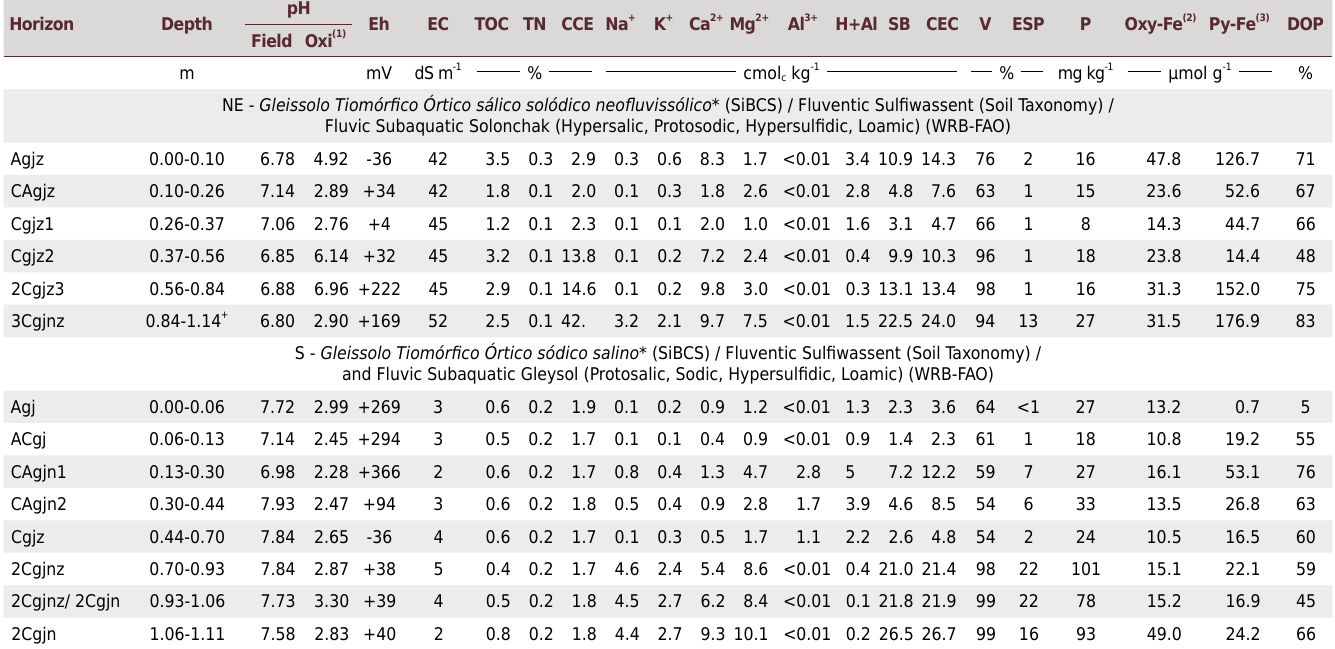
66 (1) pH values recorded after sample oxidation with H (2) Iron associated to oxyhydroxides. (3) Iron associated to pyrite. Eh = redox potential; EC 2 O 2 . = electrical conductivity; TOC = total organic carbon; TN = total nitrogen; CCE = calcium carbonate equivalent; SB = sum of bases; CEC = cation exchange capacity; V = base saturation; ESP = exchangeable sodium percentage; DOP = degree of pyritization. * The terms neofluvissólico and salino were included to better classify the soils of the NE and S coast, respectively. Soil samples (after the removal of soluble salts) were analyzed according to the methods proposed by Claessen (1997) and Santos et al. (2013a,b). Total organic carbon was obtained by elemental analyzer after samples acidification; total nitrogen was obtained by elemental analyzer using untreated samples (Howard et al., 2014). Iron fractions (i.e., Oxy-Fe and Py-Fe) were obtained according to Lord III